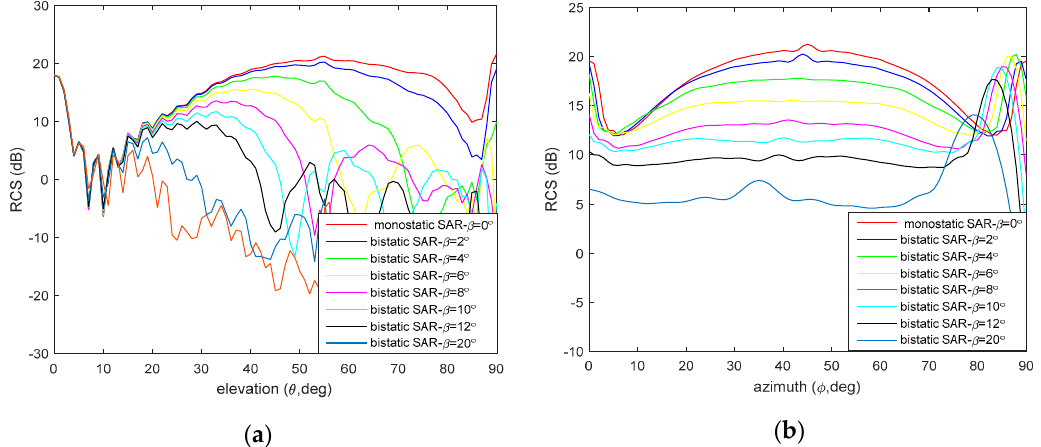
Figure 8. The bistatic RCS pattern of the TCR based on FEKO electromagnetic simulations as the TCR boresight changes with the bistatic angle is considered. ( a ) The bistatic RCS elevation pattern of the TCR; ( b ) the bistatic RCS azimuth pattern of the TCR.